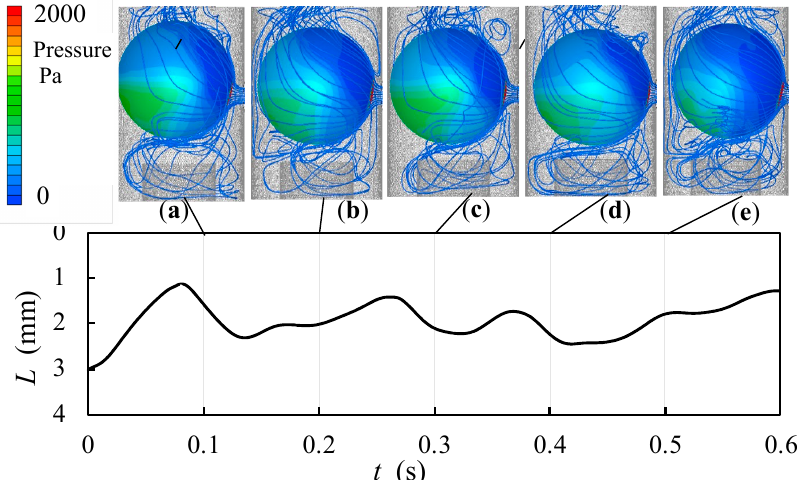
Figure 9. Time variation of lift for low-viscosity case with three degrees of freedom of Model (b); Streamlines and ball surface pressure distribution ( a ) 0.1 s, ( b ) 0.2 s, ( c ) 0.3 s, ( d ) 0.4 s ( e ) 0.5 s.